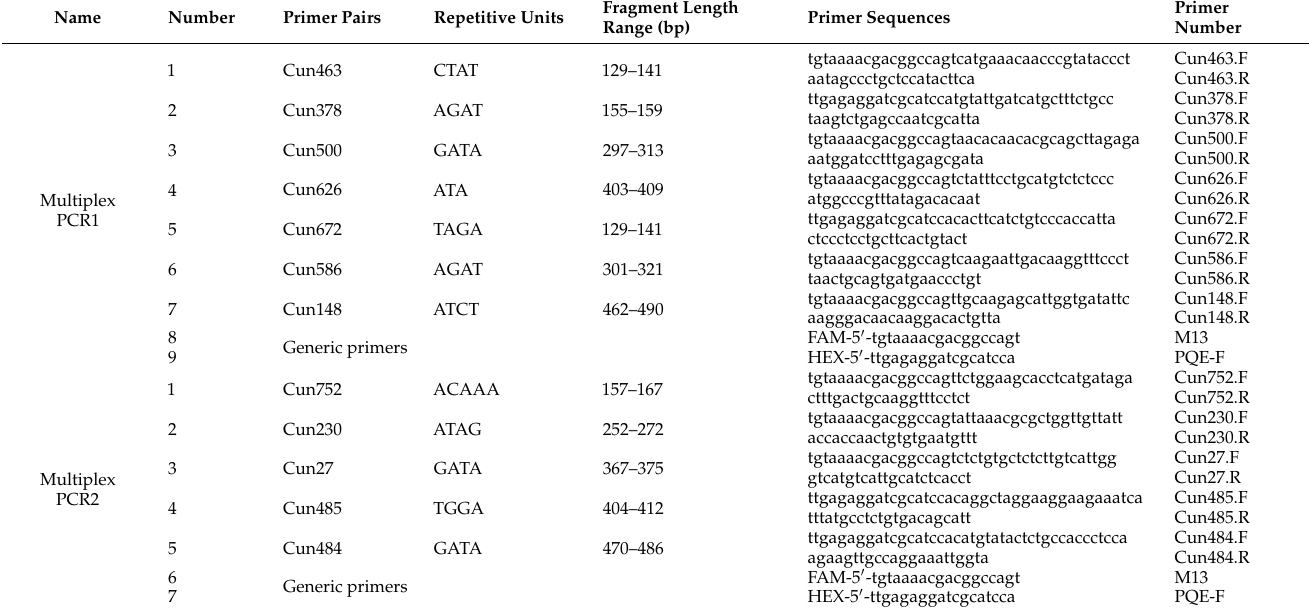
Table 1. Information about site combination and primer concentration of Multiplex PCR1 and Multiplex PCR2.